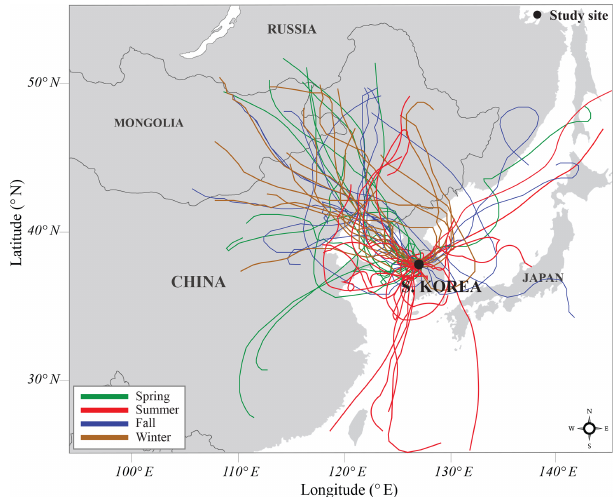
Figure 1. Map of the geographical region around the study site and air mass transport pathways in the different seasons: spring (green), summer (red), fall (blue), and winter (brown). The 10d air mass back trajectory was drawn by using the HYSPLIT model from March 2015 to January 2016 in Seoul, South Korea.